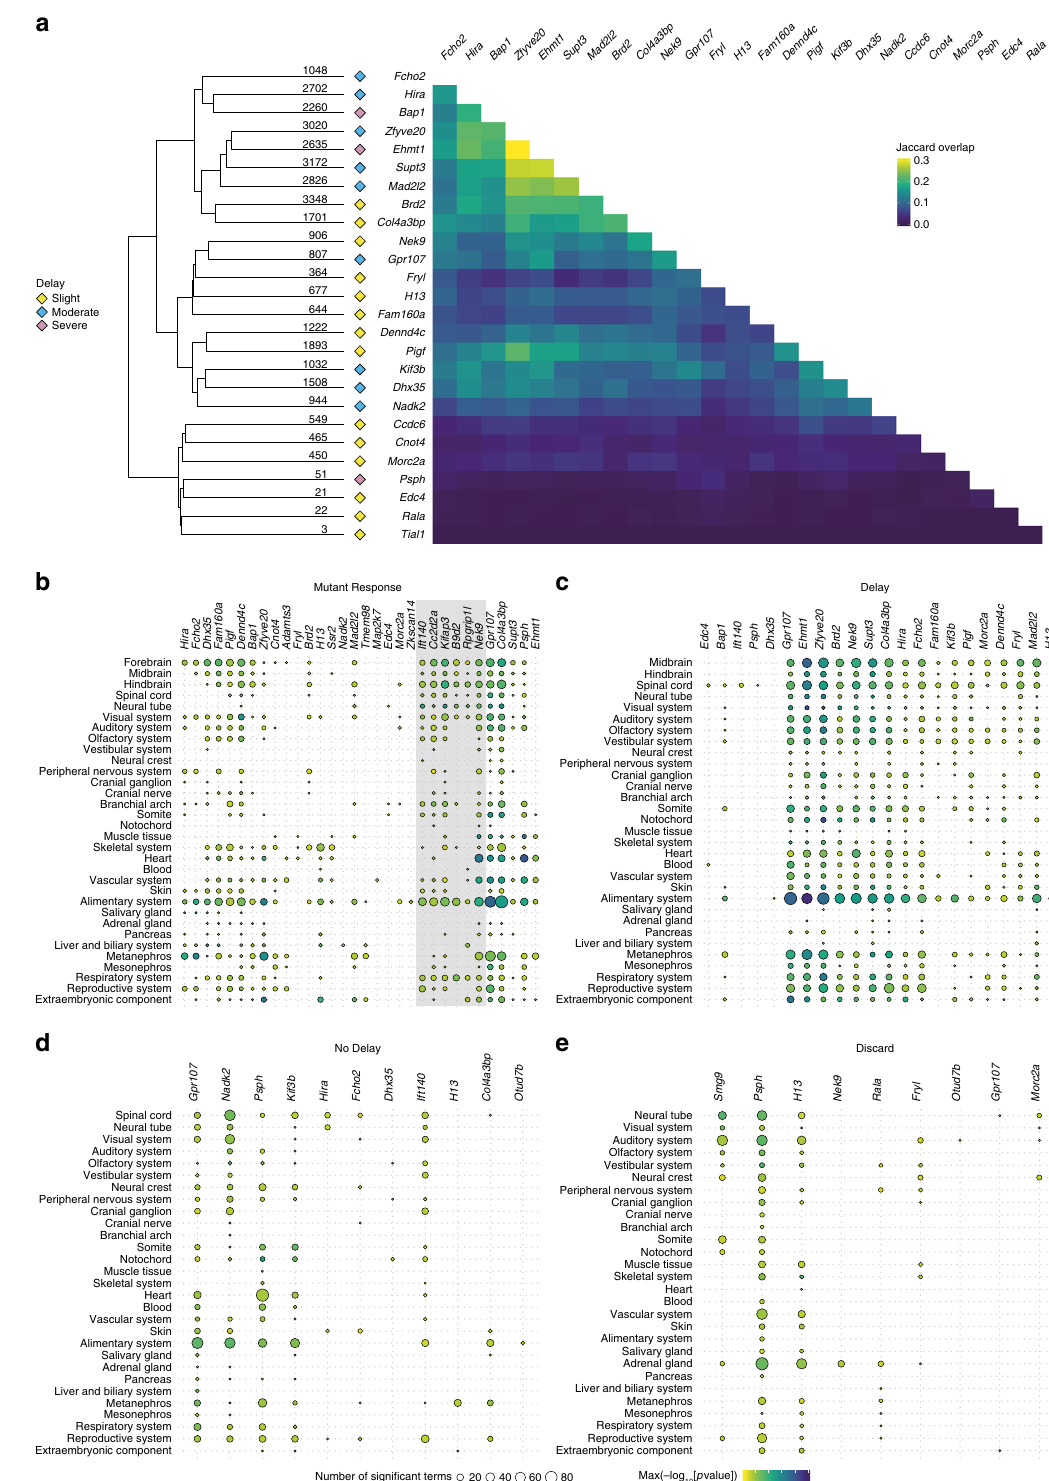
(Fig. 7b). In contrast to the other 11 lines, DERs in the Dhx35 line were mostly intronic whereas those in Morc2a were mostly intergenic (Fig.